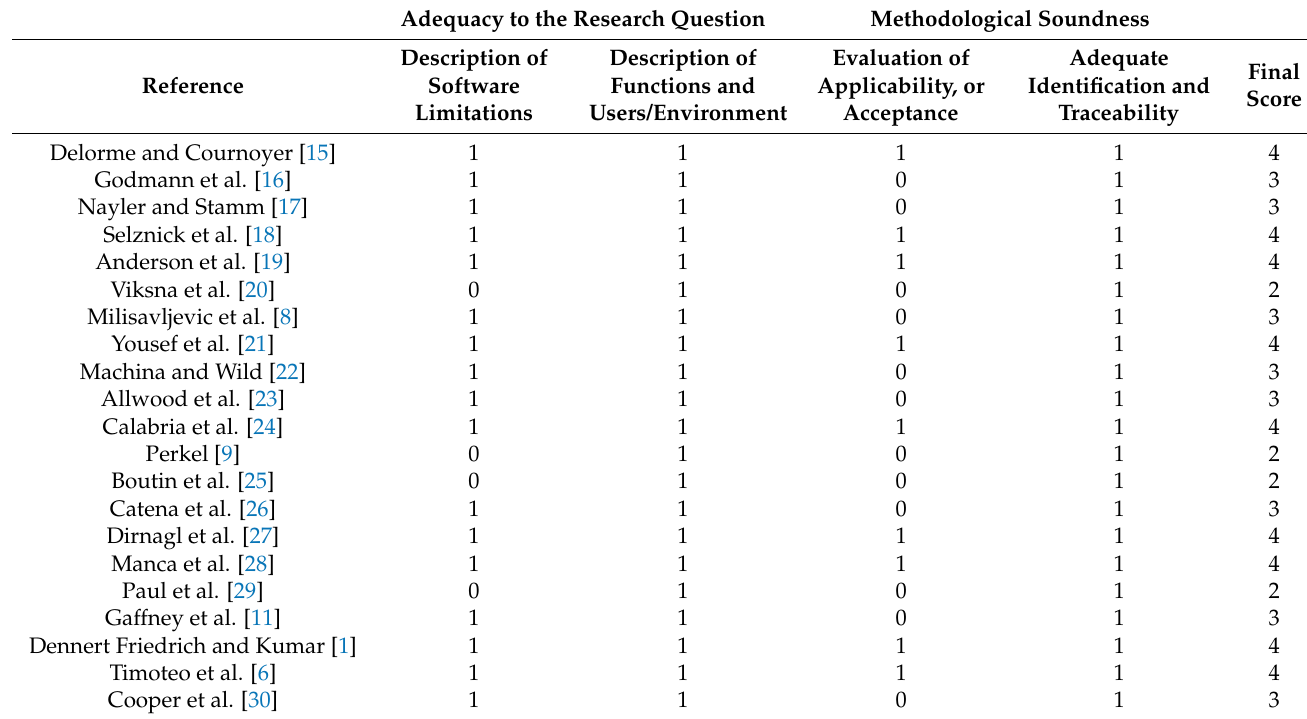
Table 2. Critical appraisal of the sources of